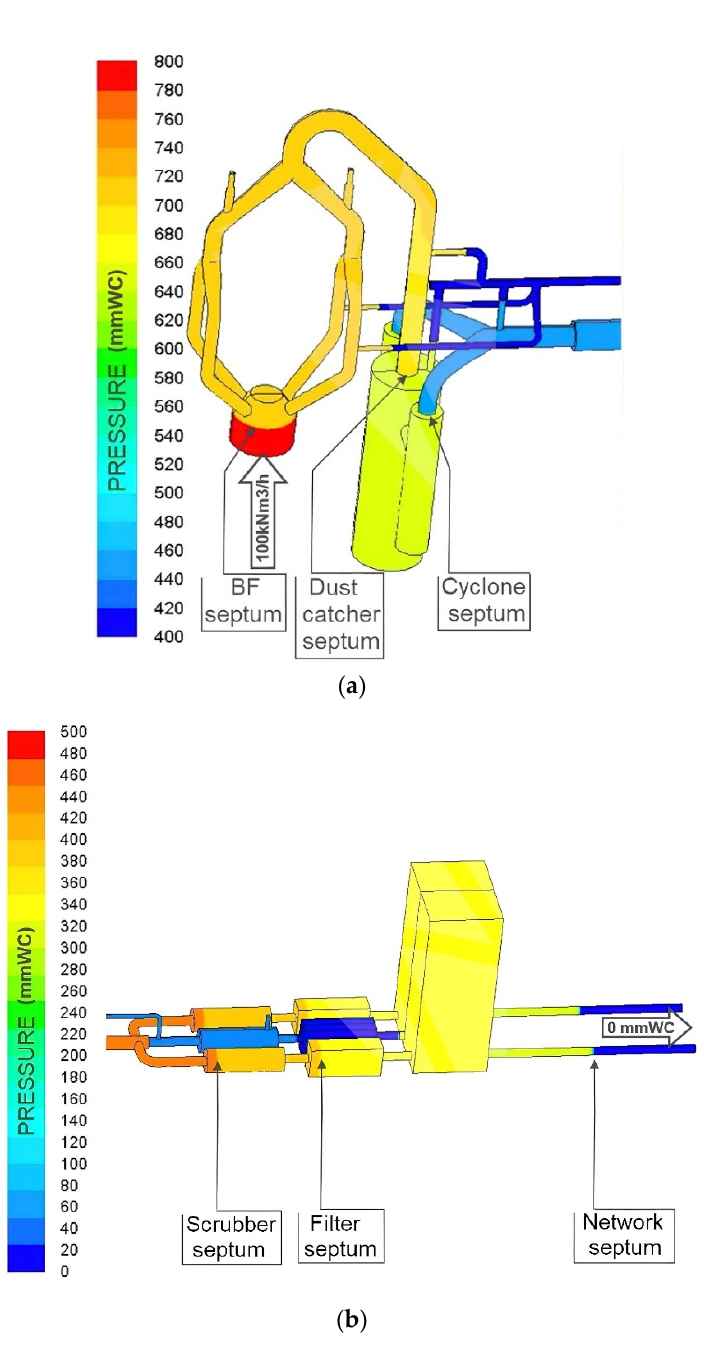
Figure 6. Detail of surfaces acting as porous jump (septum): ( a ) upstream circuit; ( b ) downstream circuit. Pressure values refer to normal operating conditions.